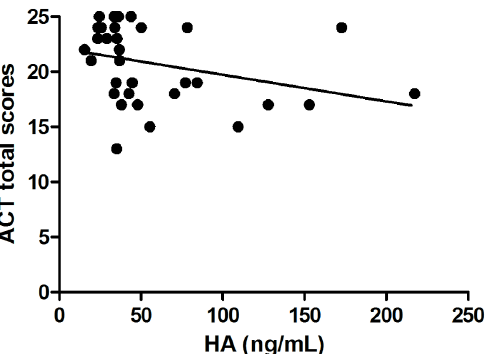
Figure 6. ROC analysis of HA values in the whole asthmatic cohort with controlled and uncontrolled disease according to ACT total score. HA – hyaluronic acid; ACT – asthma control test.